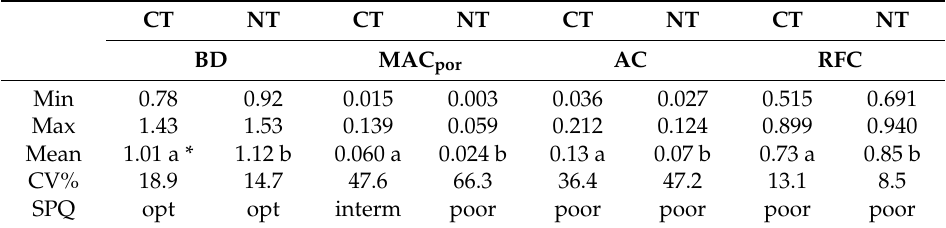
Table 2. Minimum (Min), maximum (Max), mean, and associated coe ffi cient of variation (CV%) of soil bulk density (BD), macroporosity (MAC por ), air capacity (AC) and relative field capacity (RFC), obtained from the whole set of data (FO + MA; 98 + 204 cm 3 ) under conventional tillage (CT) and no-tillage (NT). A soil physical quality (SPQ) assessment was reported. CT NT CT NT CT NT CT NT BD MAC por AC RFC Min 0.78 0.92 0.015